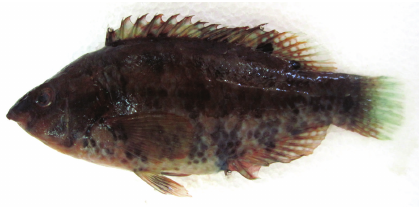
Figure 3: Symphodus bailloni , 13.1cm standard length, from western Black Sea coast of